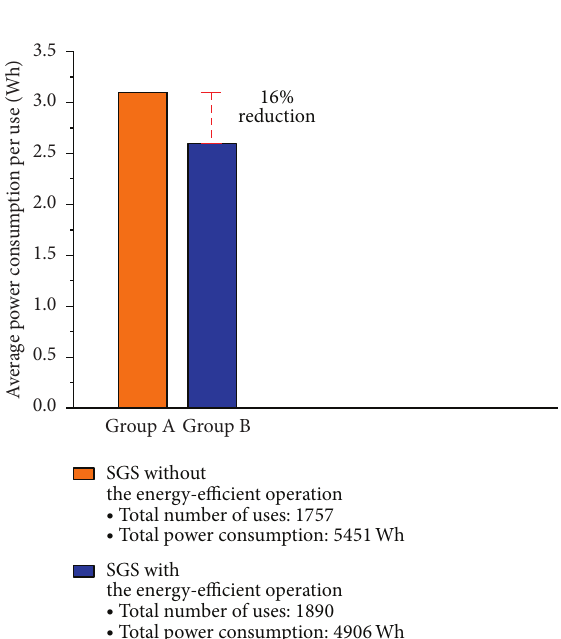
Figure 11: Web-based food waste management service.